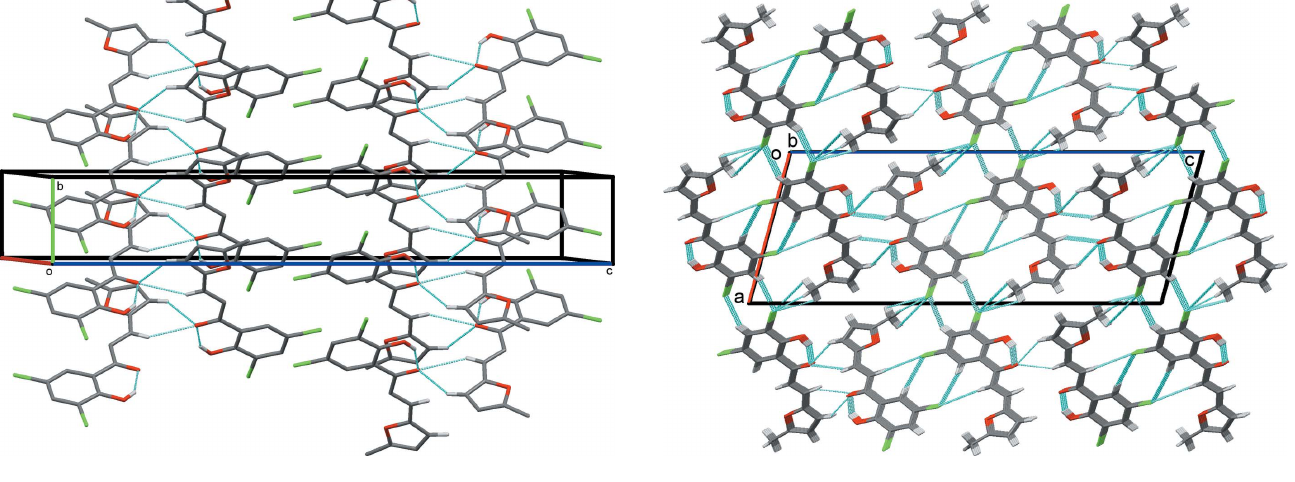
Figure 2 A view normal to the bc plane of the crystal packing of the title compound. The hydrogen bonds (Table 1) are shown as dashed lines and only the H atoms involved in these interactions are shown.